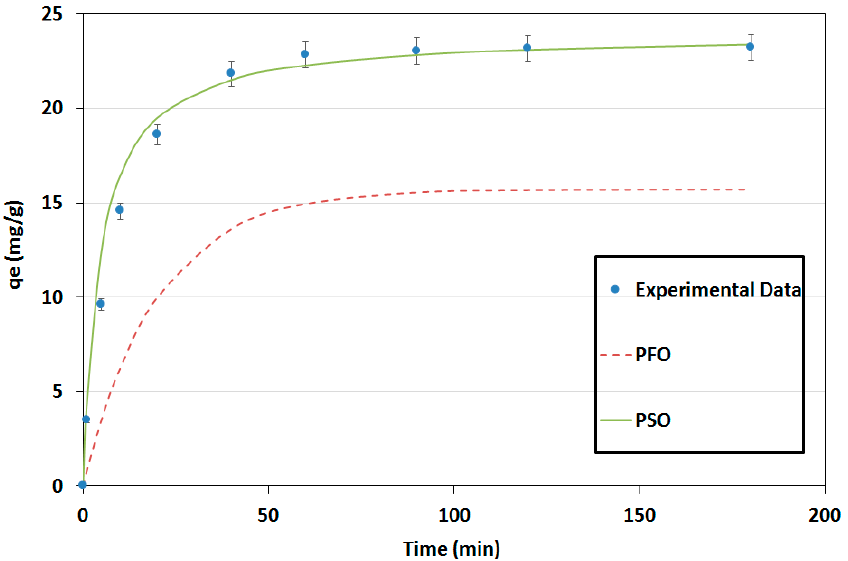
Figure 1. MB kinetic adsorption onto TiO 2 and their fitting by pseudo-first-order and pseudo-second-order kinetic models (C 0 = 60 mg/L; pH neutral; DTiO 2 = 1 g/L; temperature = 20 ± 2 °C).